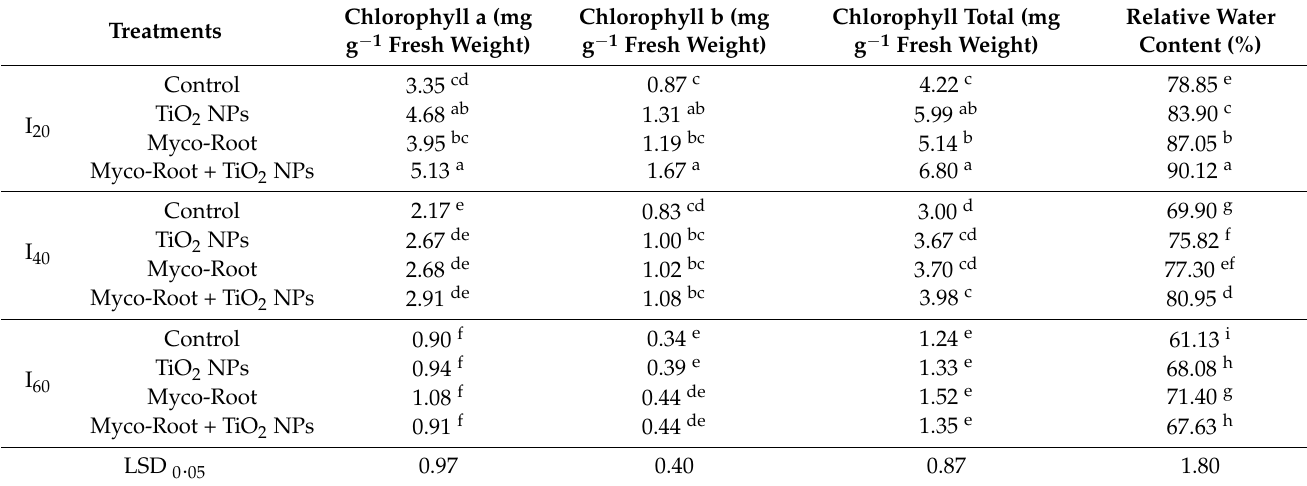
Table 6. Chlorophyll a, b, total, and relative water content of peppermint in different irrigation regimes and fertilizer